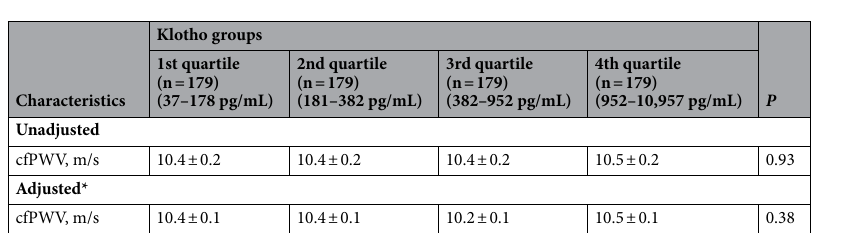
Table 4. Pulse wave velocity in relation to the serum klotho concentration. Values are presented as means ± standard errors. *Values are adjusted for age, sex, body height, pulse rate, glomerular filtration rate, hypertension, diabetes status, antihypertensive treatment, current smoking, and alcohol intake. cfPWV carotid–femoral pulse wave